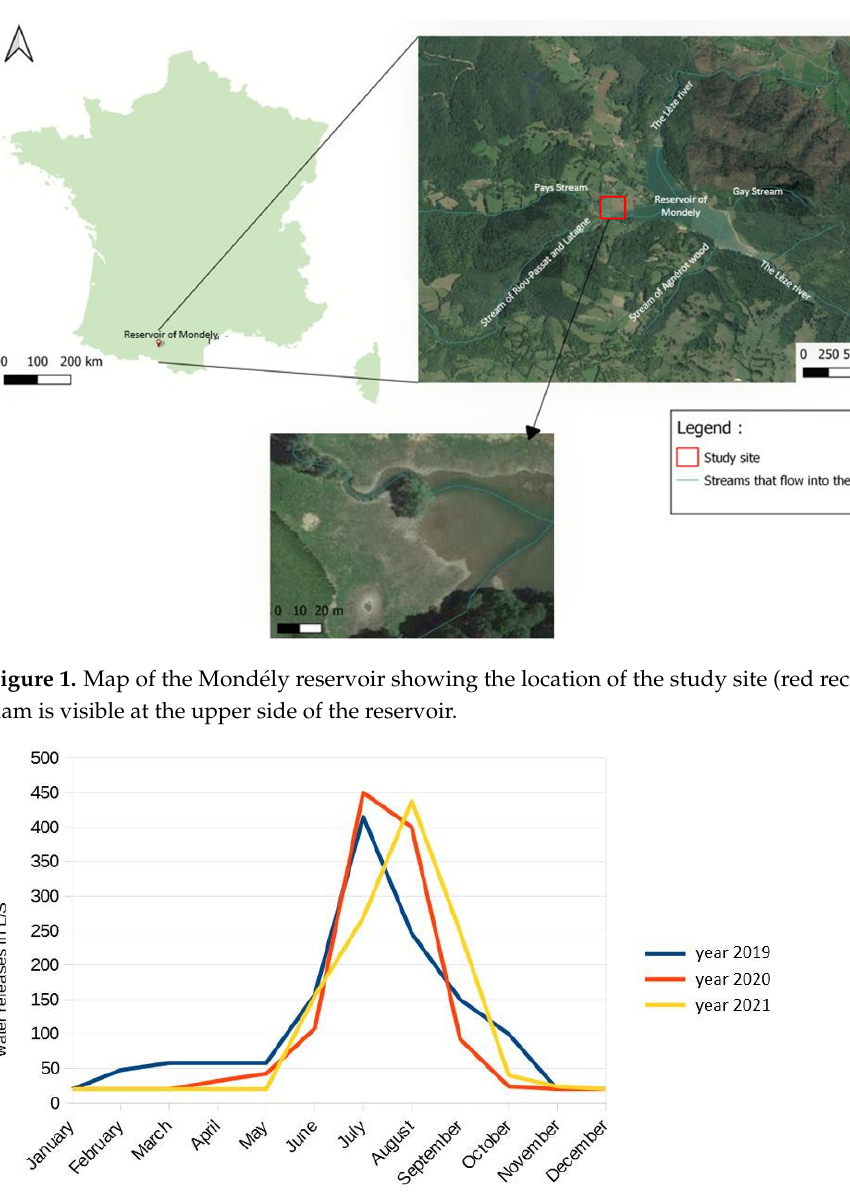
Figure 2. Dynamics of water release at the Mondély reservoir dam during the period 2019 – 2021 (data courtesy of the SHMVL).